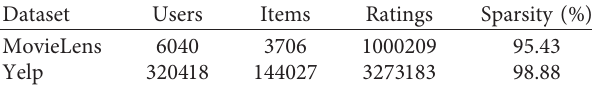
Table 1: Experimental